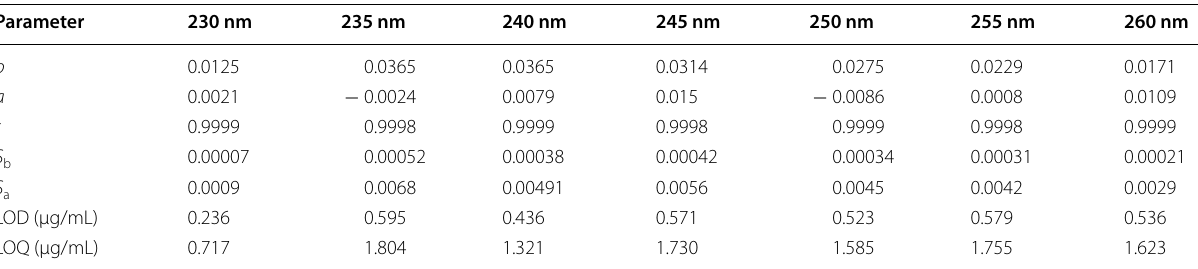
b slope, a intercept, r correlation coefficient, S b standard deviation of the slope, S a standard deviation of the intercept, LOD limit of detection, LOQ limit of quantitation Table 3 Amlodipine linearity data (absorbance factor method)